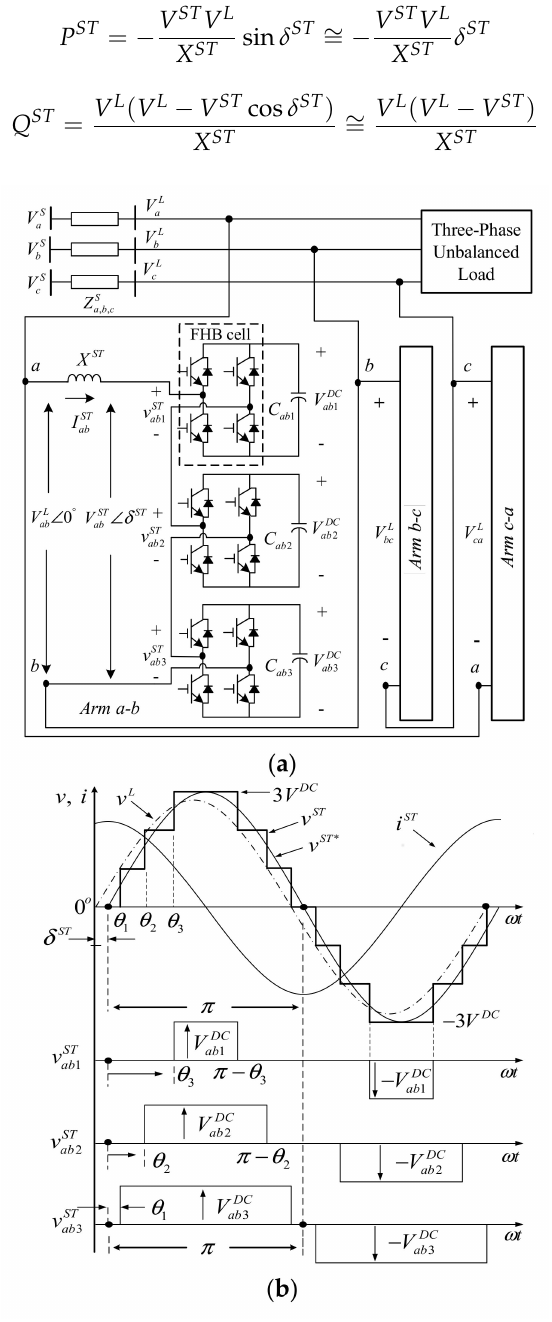
Figure 1. The studied system ( a ) three-phase unbalanced load and the proposed STATCOM; ( b ) Current and voltage waveforms of the STATCOM arm a-b (charging mode, δ ST <